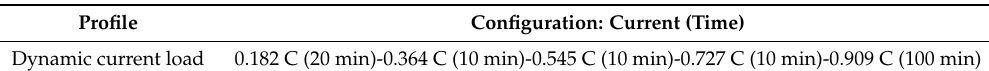
Table 4. Profile configuration of dynamic current load.